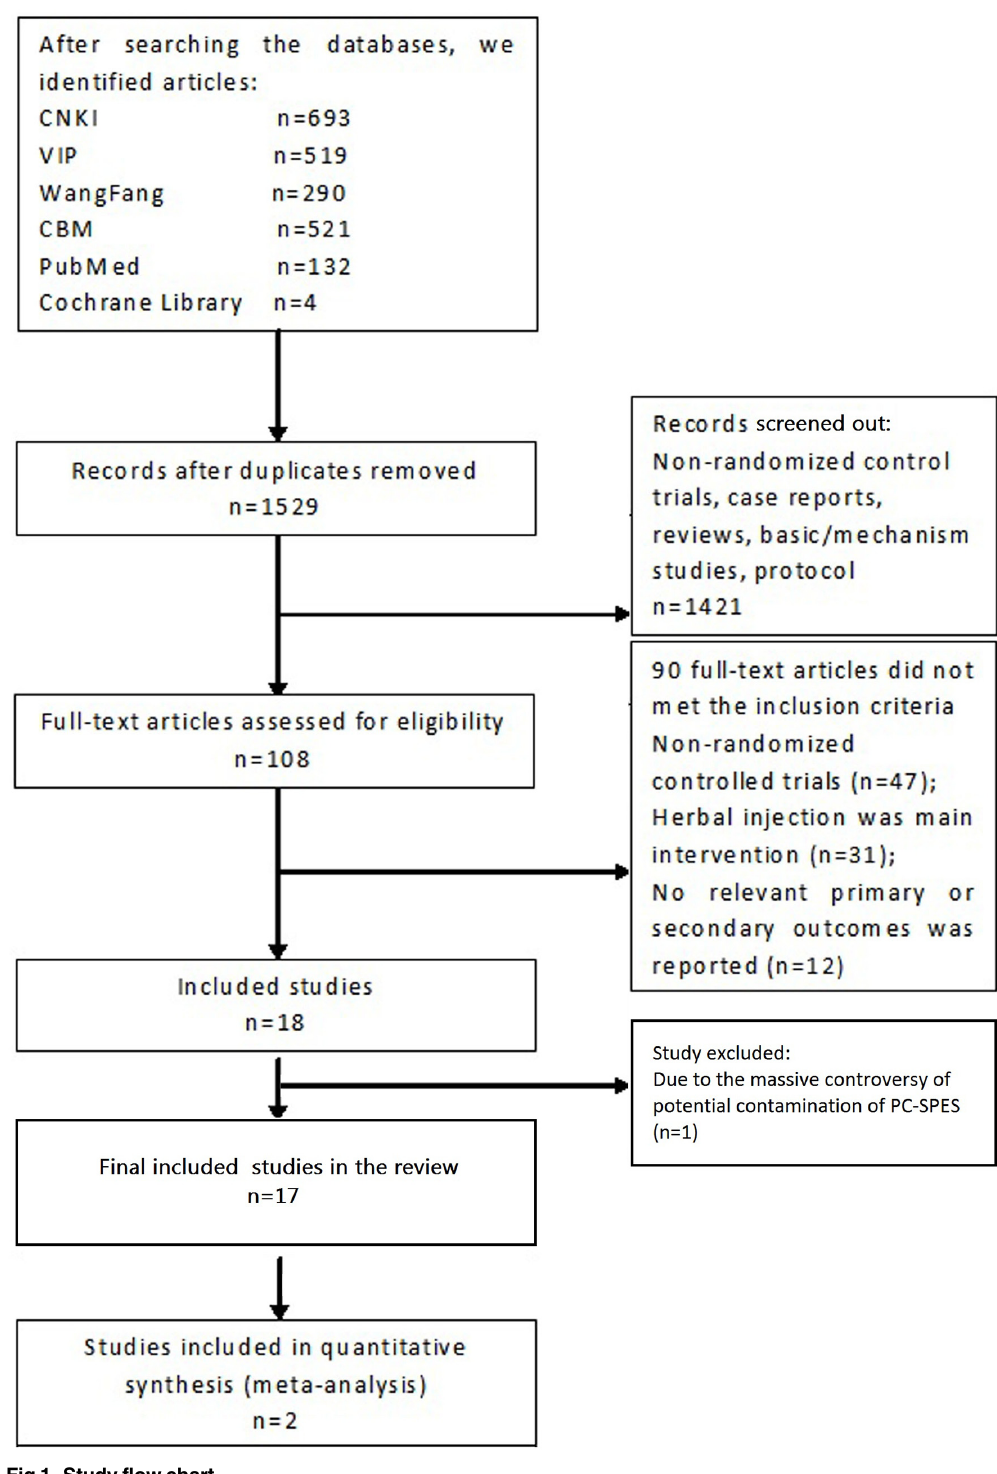
Fig 1. Study flow chart.